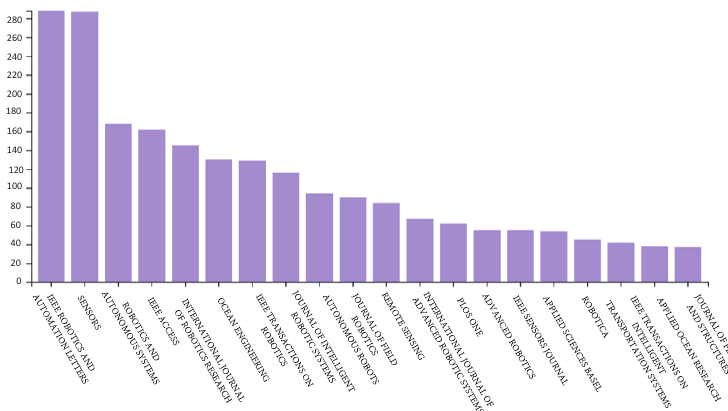
Figure 6. Publication titles about SLAM on Web of